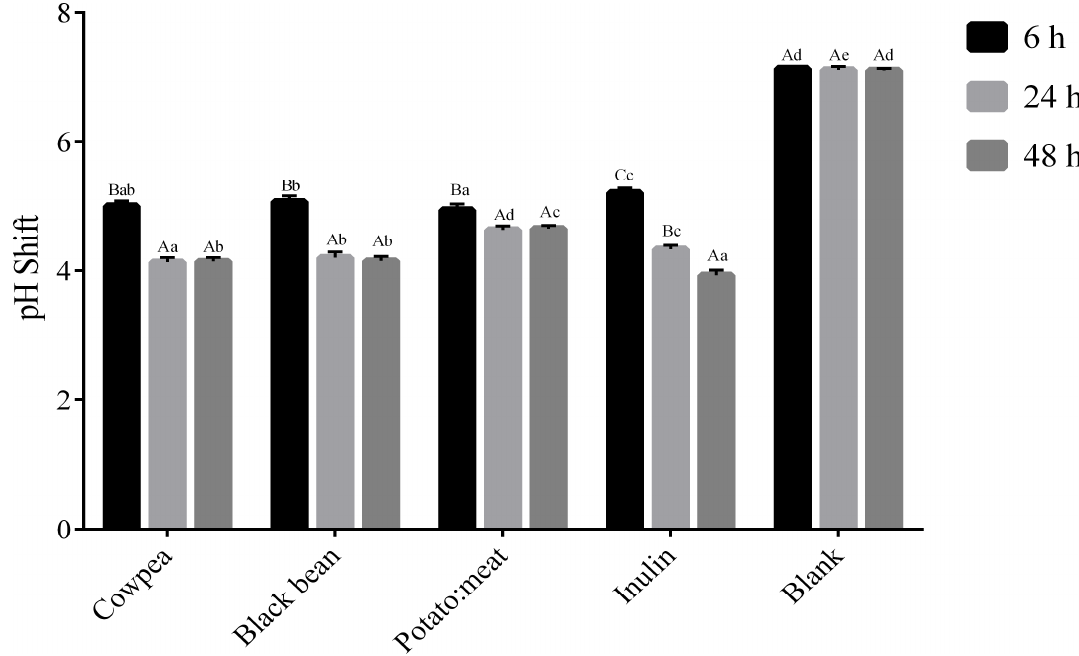
Figure 2. pH shift during fermentation time (6, 24 and 48 h). Results presented as mean and standard deviation ( n = 3). The data marked by the same letters were not significantly different ( p > 0.05). Different uppercase letters for comparison within each fermentable source at a different time and lowercase letters for comparison within the different fermentable source at the same time, indicating significant differences at p < 0.05.